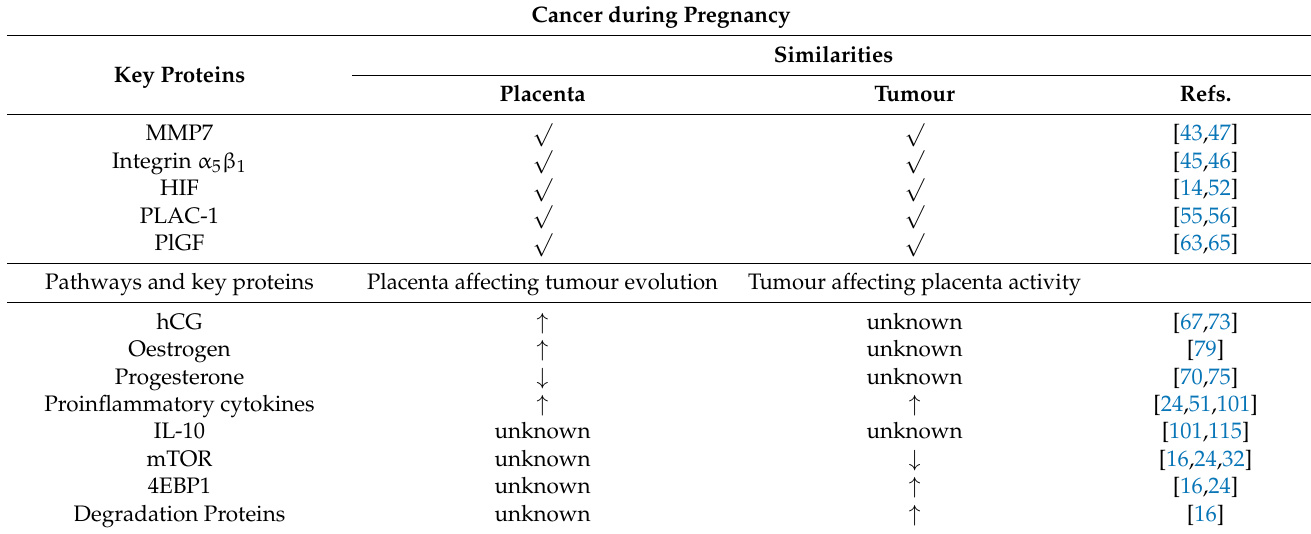
Table 1. Molecular similarities between placenta and tumour tissues and molecular pathways and key proteins expression related to the placenta or tumour